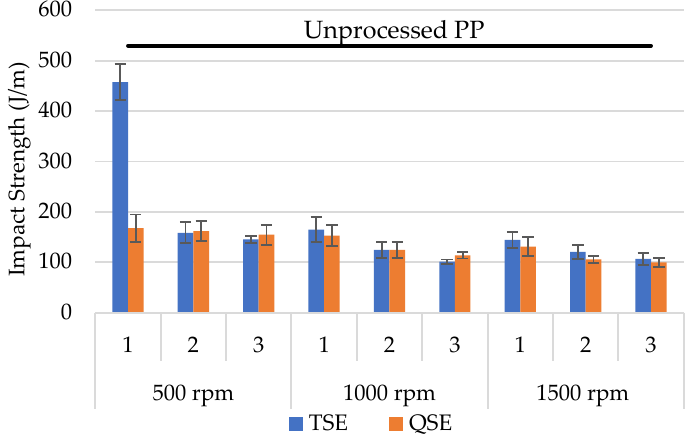
Figure 6. Notched Izod impact strength for polypropylene reprocessed using a TSE and a QSE with three screw speeds and three reprocessing cycles.